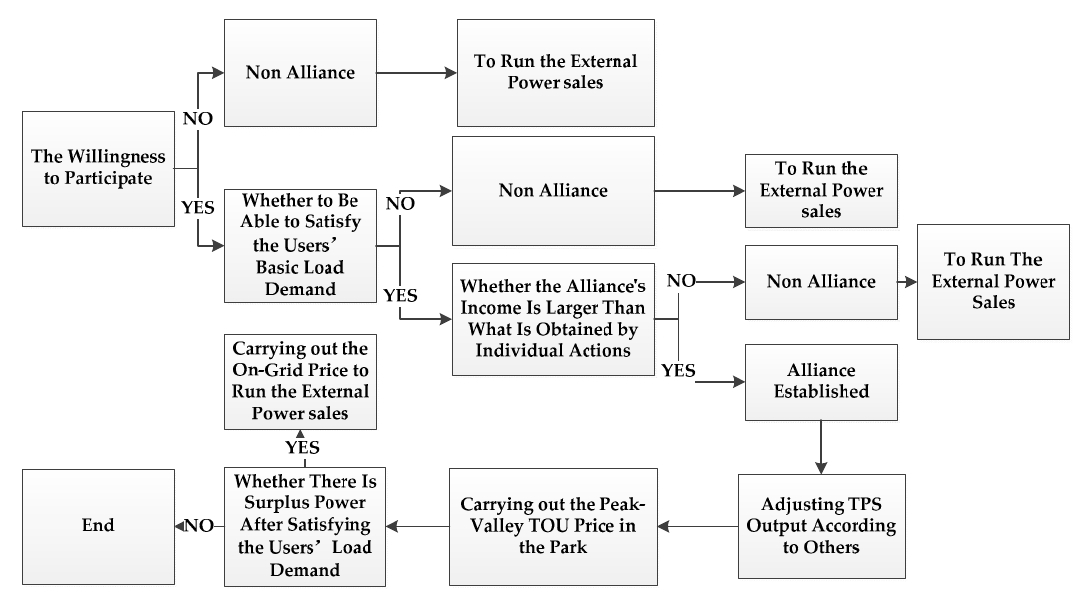
Figure 2. Conditions for the park power sales alliance